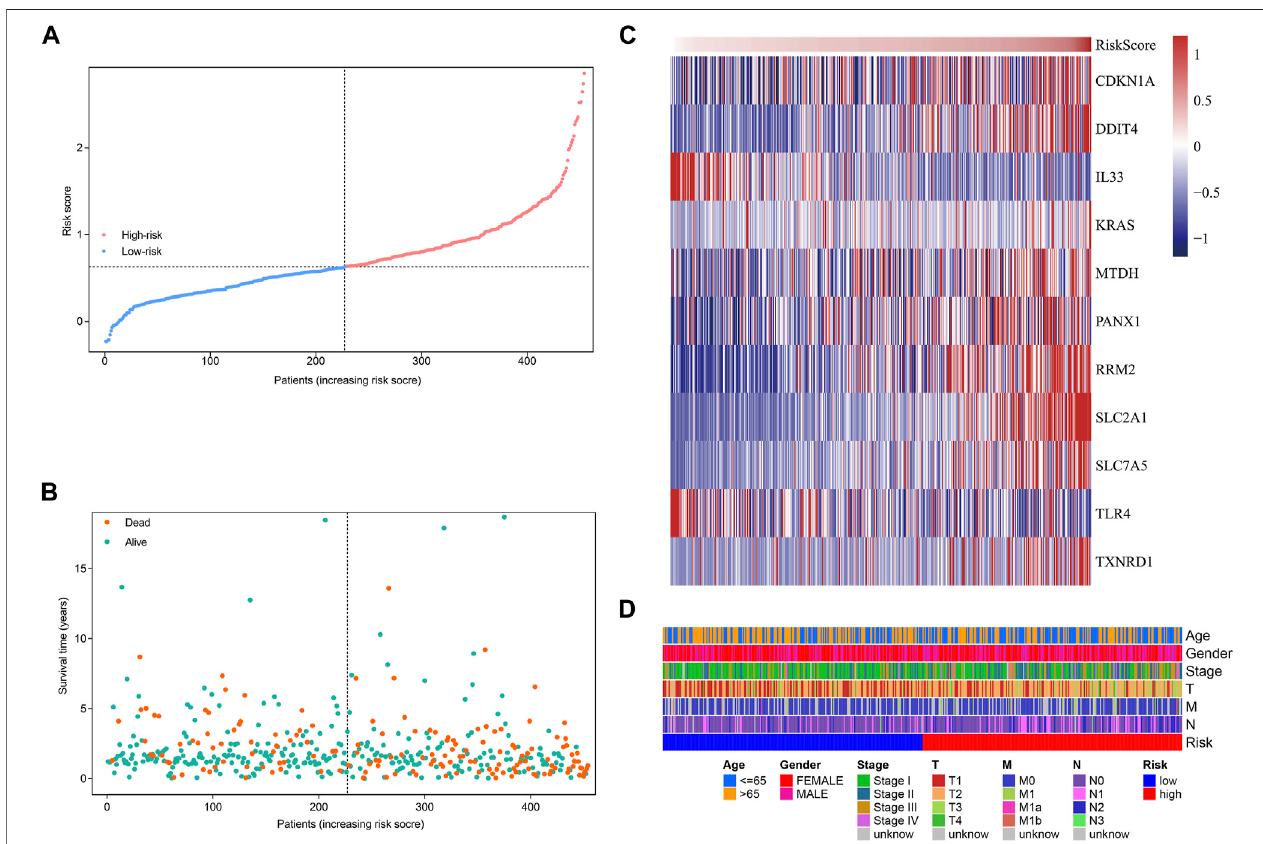
FIGURE2| Characteristicsofriskscoresandferroptosis-relatedgenesignatureintheTCGAtumorcohort. (A) Thedistributionandmedianvalueoftheriskscores. (B) The distributions of survival status, survival time, and risk score. (C) Heatmap showing the expression of model genes in two risk groups. (D) Heatmap showing the distribution of clinicopathological features in two risk